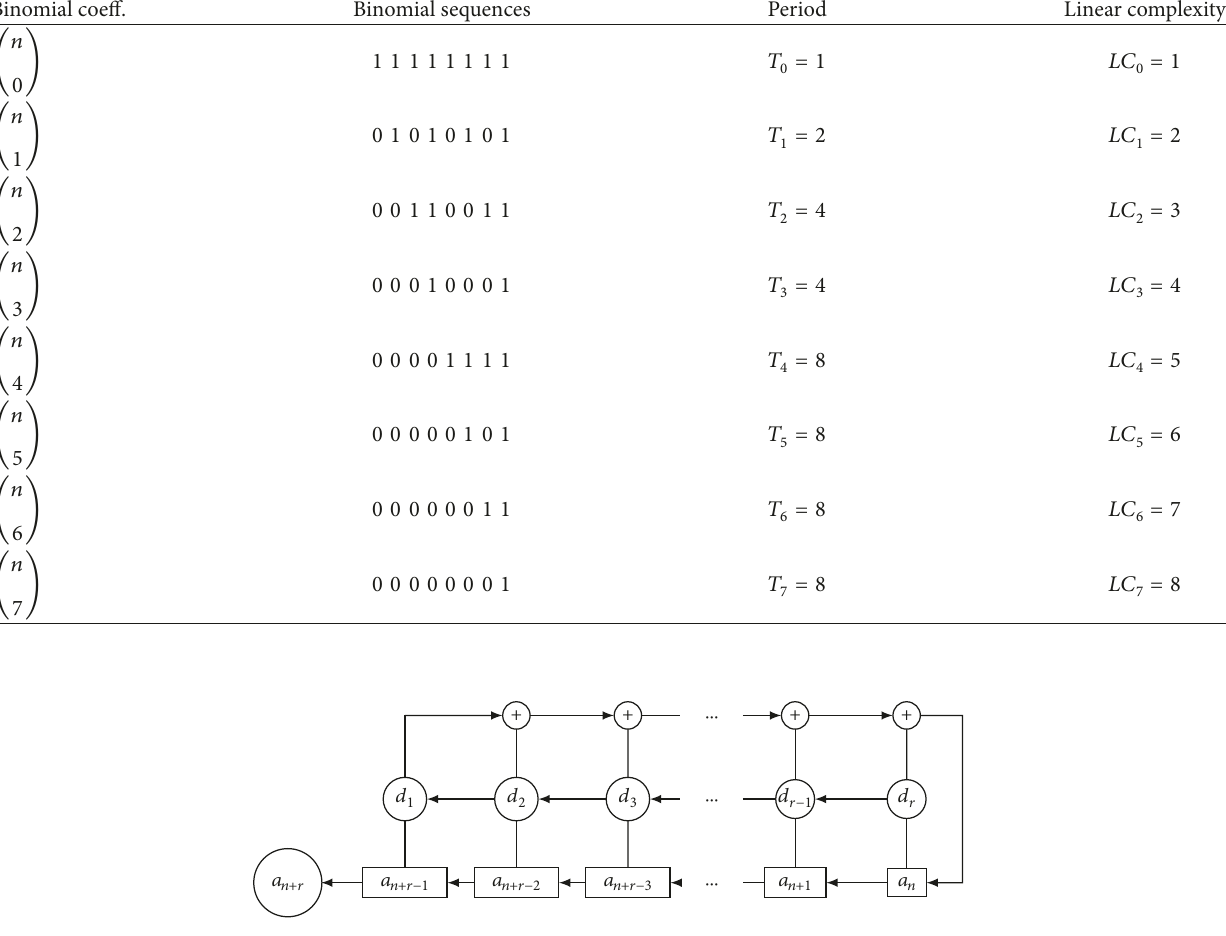
Table 1: Binomial sequences, first eight terms, period, and linear complexity. Binomial coeff.